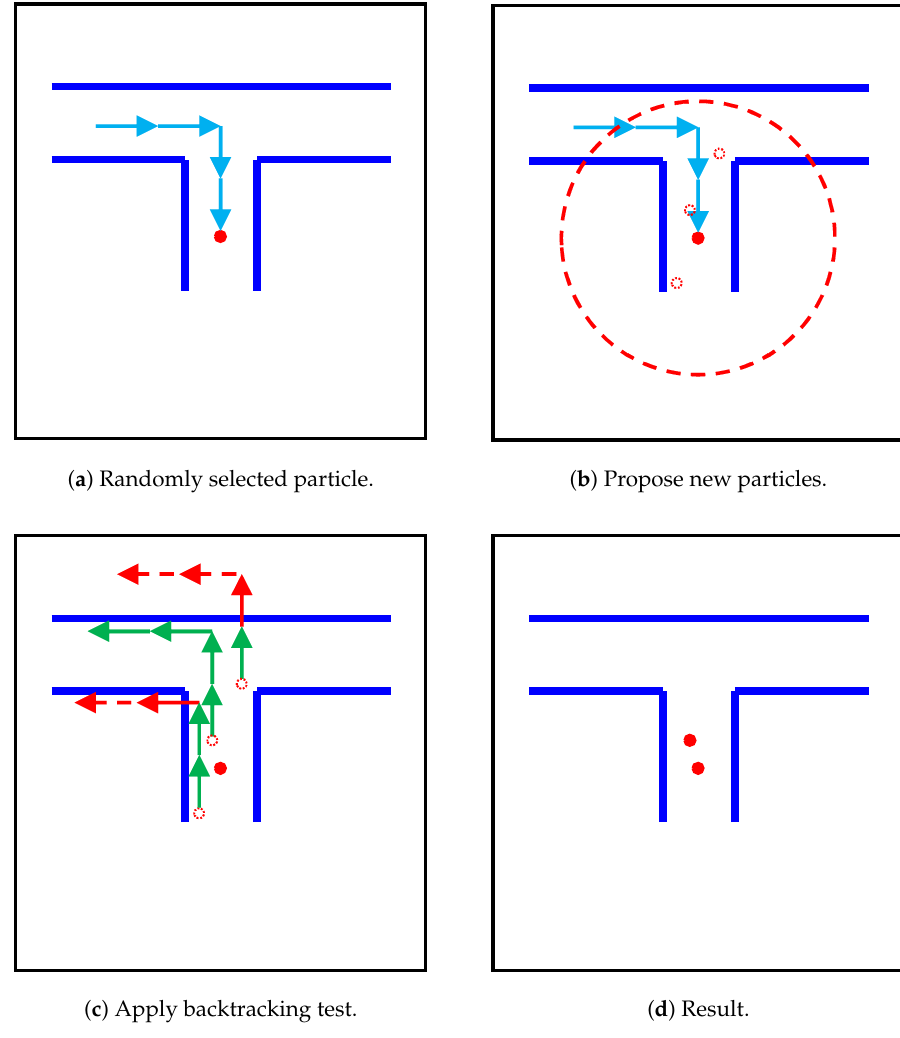
Figure 9. Process of backtracking test. Blue arrows are recent